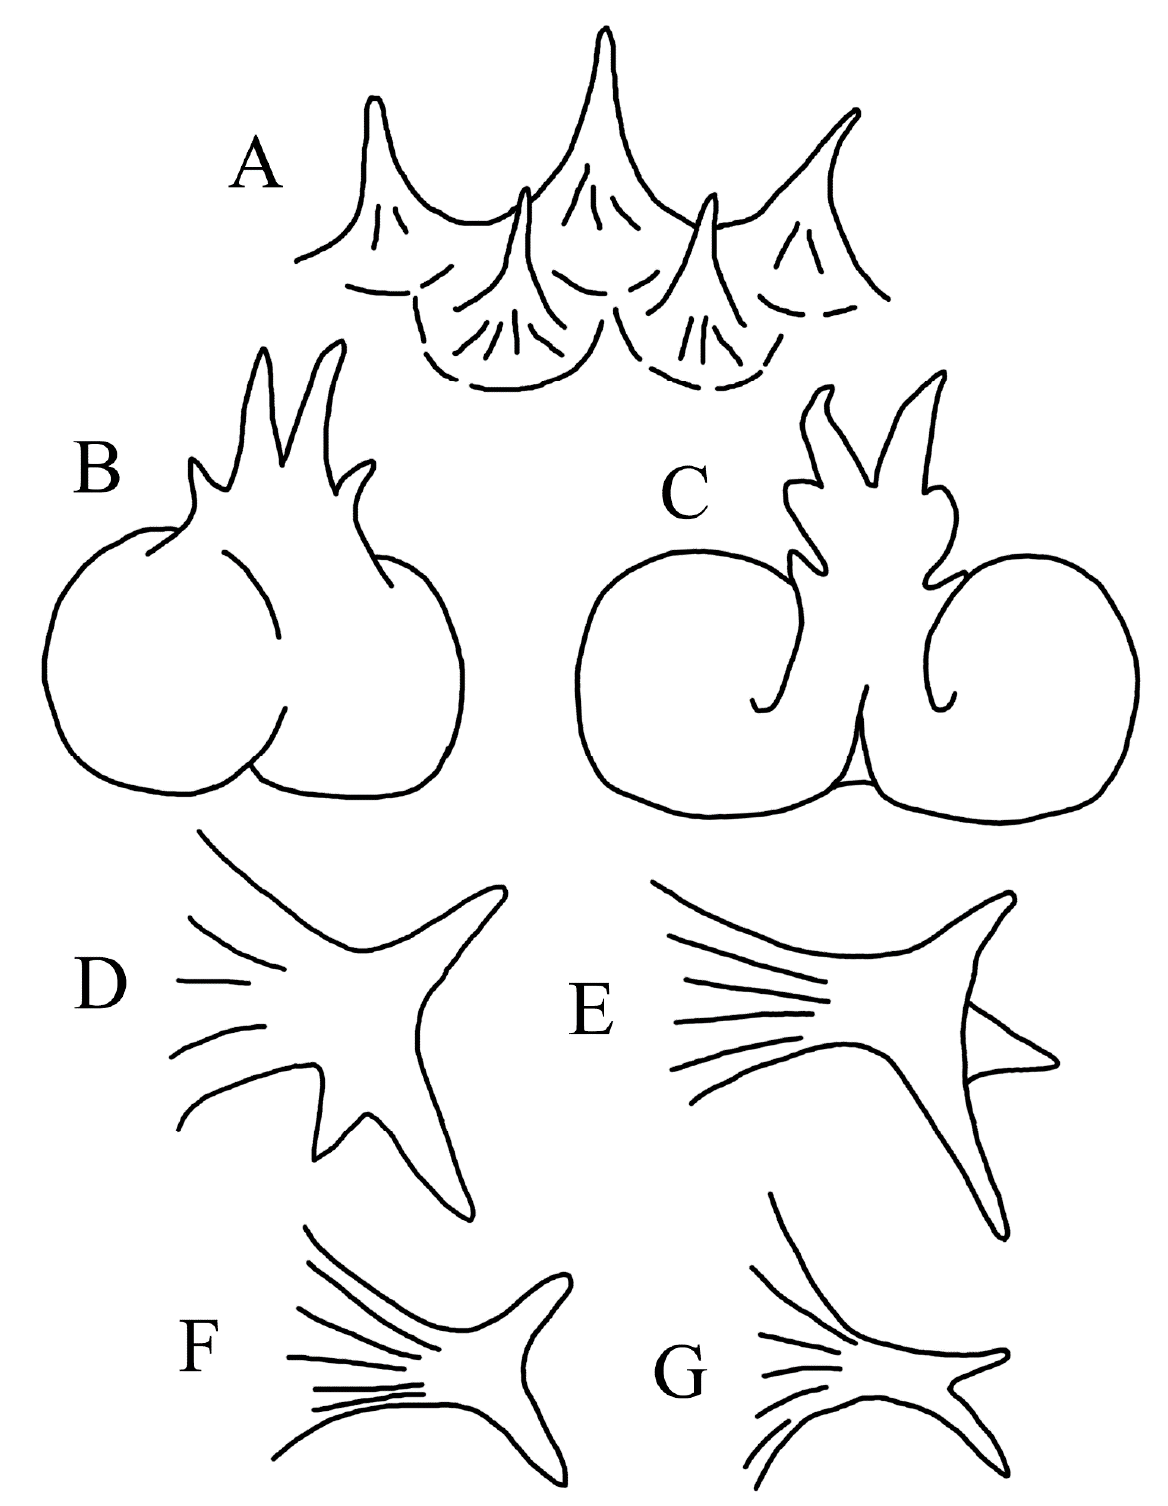
Figure 21. Esca and squamation of H. nasuta (Alcock, 1891). ( A ). Rostrum. ( B , C ). Esca. ( D , E ). Subopercular tubercle. ( F ). Tubercle on disk margin. ( G ). Tubercle on tail. ( A , B , D ). From BMNH 1898.7.13.5, 46.0 mm SL. C. From AMS I.22826-048, 57.8 mm SL. ( E – G ). From AMS I.20301-009, 30.0 mm